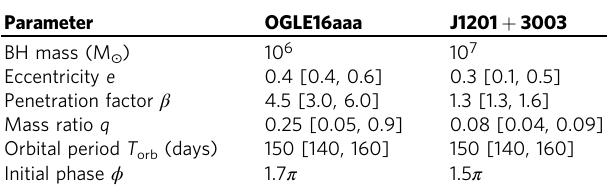
Table 3 SMBHB model parameters for OGLE16aaa and J1201 + 3003.